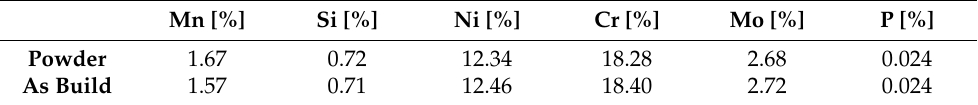
Table A2. The chemical composition post melting was measured using ICP-OES (inductively coupled plasma–optical emission spectroscopy). Next table listing the major chemical compositions of 316L stainless steel gas-atomized powders, listed in at%. As powder (pre melting) and as build (post